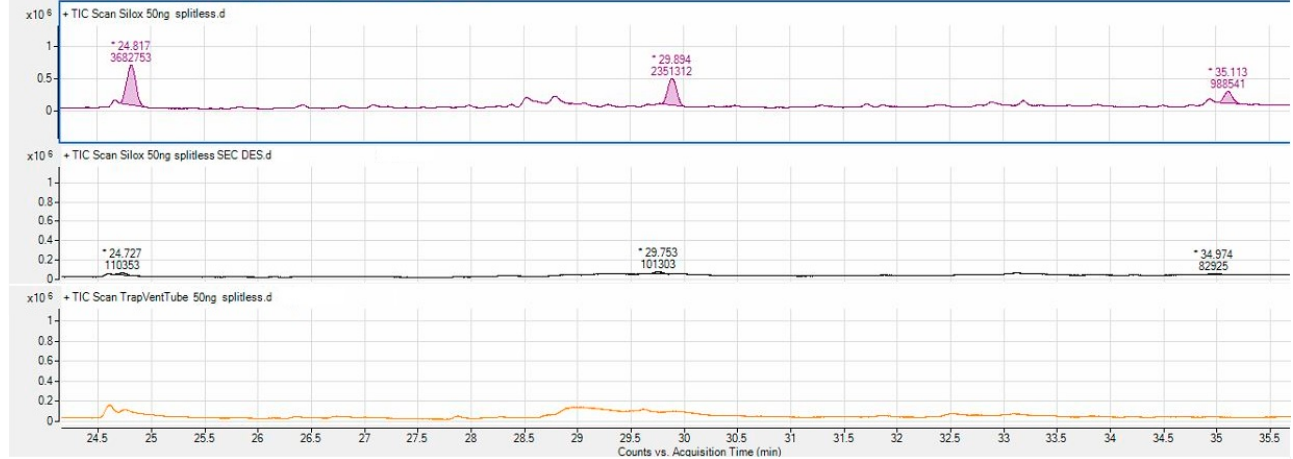
Figure 2. Chromatogram comparison of test at 50 ng. ( Above ) The first desorption with the three peaks D4, D5, and D6. In the ( middle ), the residue in the second desorption. ( bottom ) The result of the backup tube.